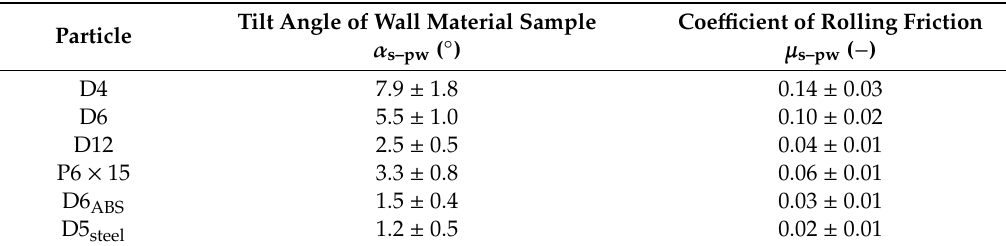
Table 10. Results of rolling friction coe ffi cients